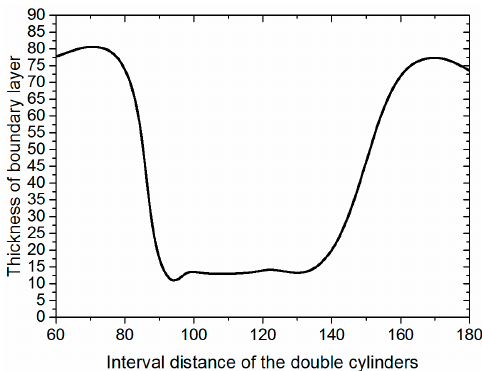
Figure 13. The thickness of the boundary layer with different interval distance of the double cylinders at x = 450 in Figure 10.